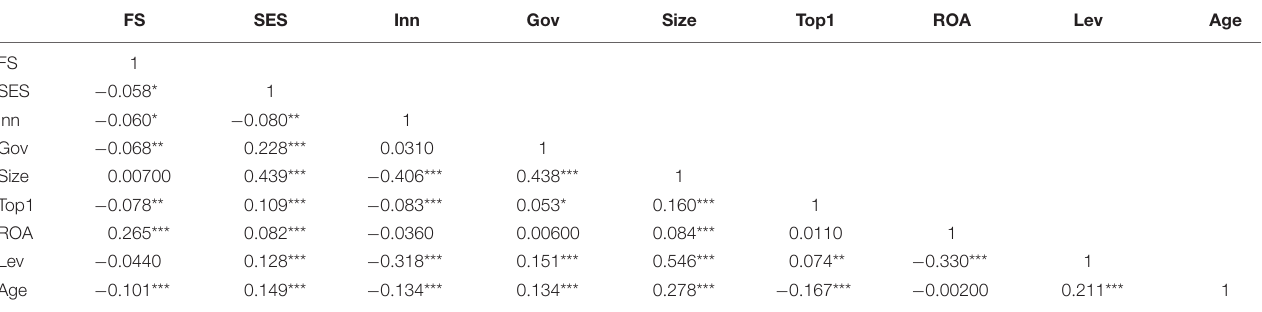
TABLE 4 | Correlations coefficients.